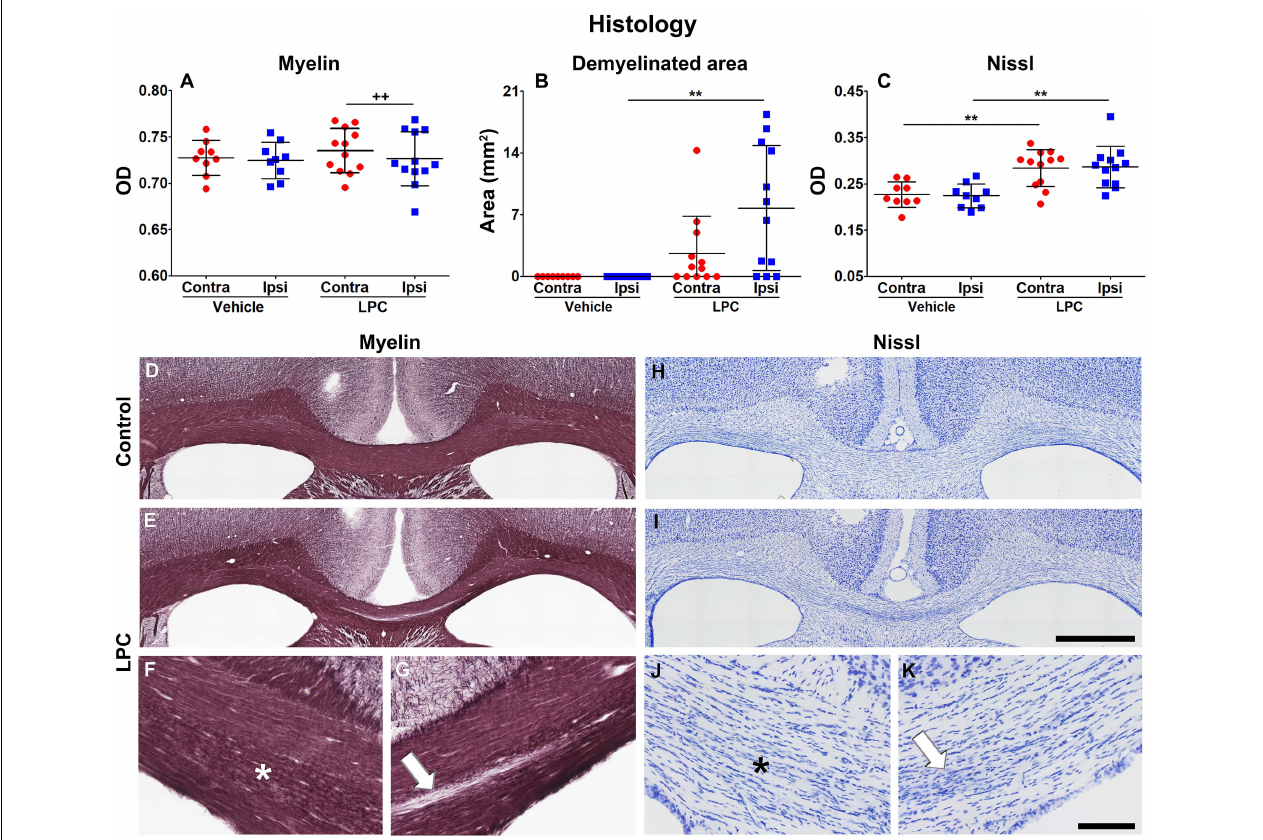
FIGURE 6 | Histologic assessment of the myelin and Nissl stainings at 38 days after vehicle or LPC injection. OD (A) and demyelinated area (B) analyses of the myelin-stained sections, and OD analysis of the Nissl-stained (C) sections. Values were obtained from the ipsi- and contralateral corpus callosum of vehicle- ( n = 9) and LPC-injected ( n = 12) rats. Results are shown as mean ± SD . The unpaired t -test compared the same hemispheres between vehicle- and LPC-injected rats (** p < 0.01), and the paired t -test ipsi- and contralateral hemispheres within the same animals ( ++ p < 0.01). Photomicrographs of vehicle- and LPC-injected animals in myelin (D–G) and Nissl (H–K) stains of representative rats. The white arrow points to the ongoing demyelinated area and the presence of gliosis, and the asterisk indicates the area with ongoing myelin alterations accompanied by gliosis. Scale bar: 1 mm (D,E,H,I) and 200 µ m (F,G,J,K) .